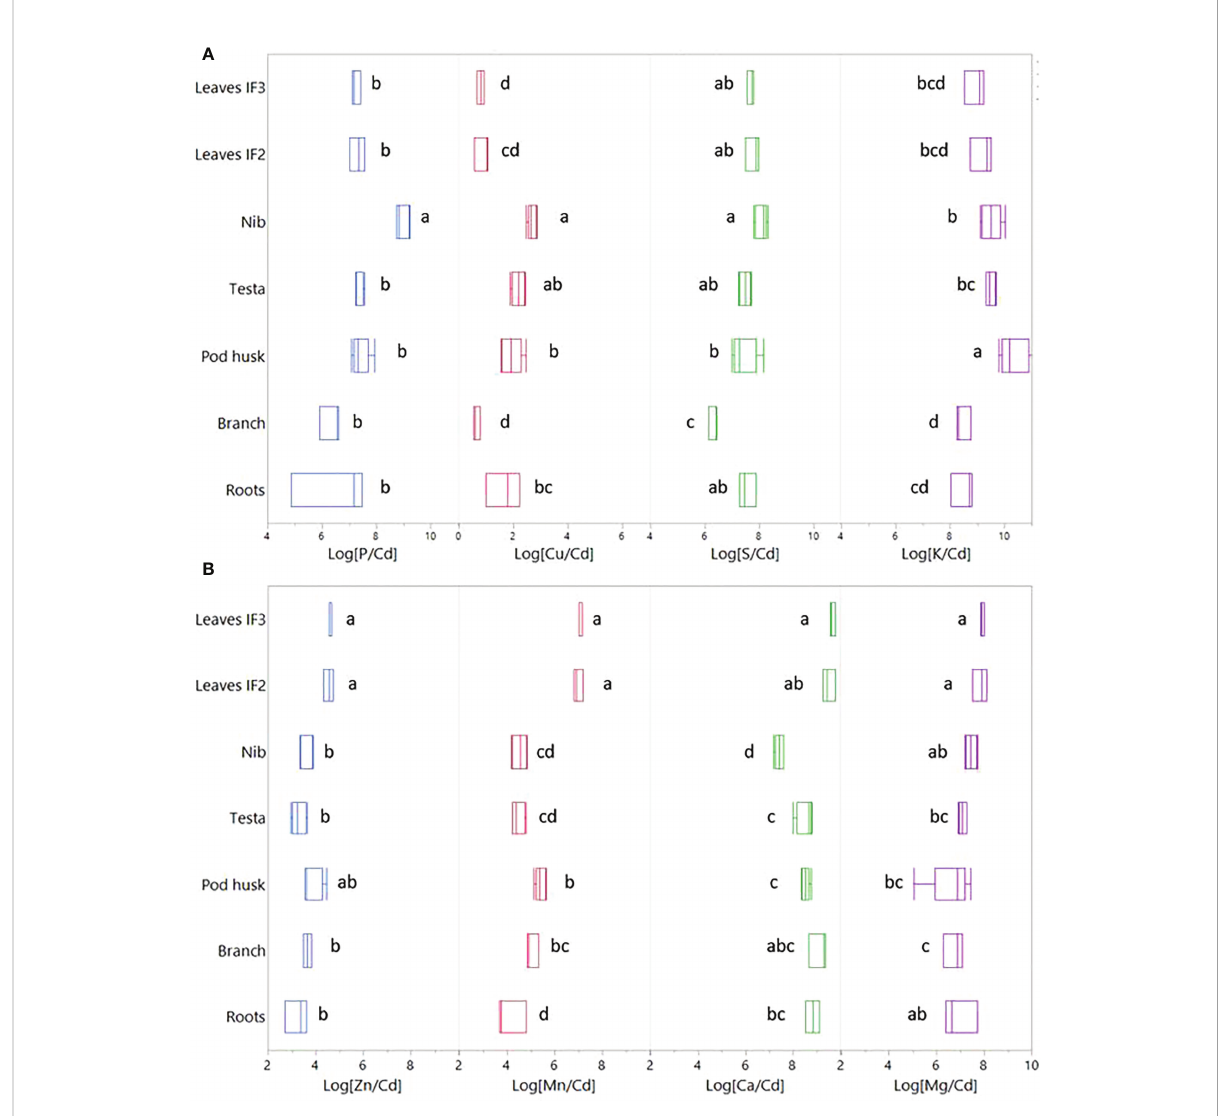
FIGURE 2 Bulk concentration ratios (log[nutrient/Cd (mg kg -1 DW -1 /mg kg -1 DW -1 )]) for the different tree organs. The value of each treatment is shown ( n =3, except for fruit tissues where n =5). Letters denote statistical difference of the mean determined by Tukey HSD test ( p ≤ 0.05). (A) Group I elements that correlate positively with Cd. (B) Group II elements that correlate negatively with Cd (Figure